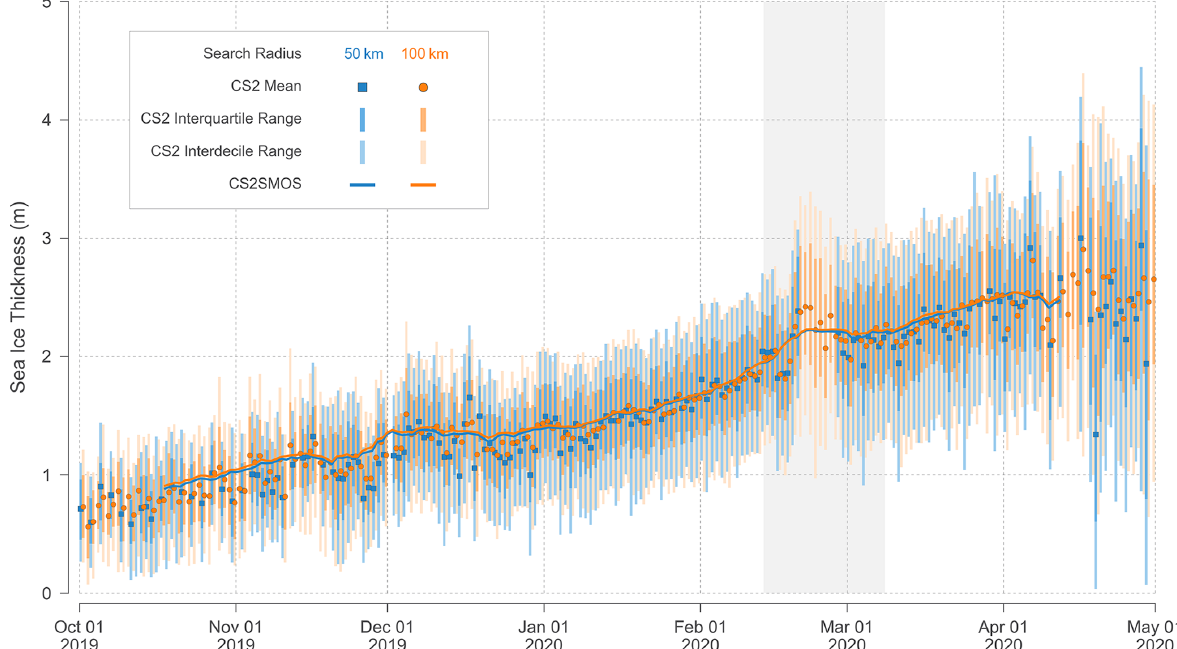
Figure 12. Daily sea ice thickness estimates from CryoSat-2 (CS2) full-resolution orbit L2P data and gridded CryoSat-2/SMOS (CS2SMOS) multi-sensor thickness analysis extracted for two different search radii (50 and 100km) centred around the noon position of the CO for each day of the drift. Results from L2P data are only present for days where at least 50 L2P data points are found in both search radii. The gray rectangle indicates when the CO drifted north of 88 ◦ N and outside the CS2 orbit coverage. The distribution of CS2 orbit data within the search radii is described by the mean value, interquartile (25% to 75% percentiles) and interdecile ranges (10% to 90% percentiles). For CS2SMOS, only the mean values of grid values within the search radius are provided. Table 2. Monthly statistics of sea ice thickness (SIT) from CryoSat-2 (CS2) level 2P (L2P) orbit and gridded CryoSat-2/SMOS (CS2SMOS) data for two radii around the CO position. The CS2 SIT distribution is characterized by the interquartile range (IQR) as the difference between the 75% and 25% percentile and the interdecile range (IDR) as the difference between the 90% and 10% percentile. For CS2SMOS, the SIT difference ( (cid:49) SIT) between the MOSAiC year and SIT from the same drift trajectory, but of previous winters since 2010, is given. The asterisk ( ∗ ) indicates that the mean SIT of CS2SMOS depends on fewer years than the other month since the CS2SMOS data record only starts in November 2010. CS2 L2P CS2SMOS SIT (m) SIT IQR (m) SIT IDR